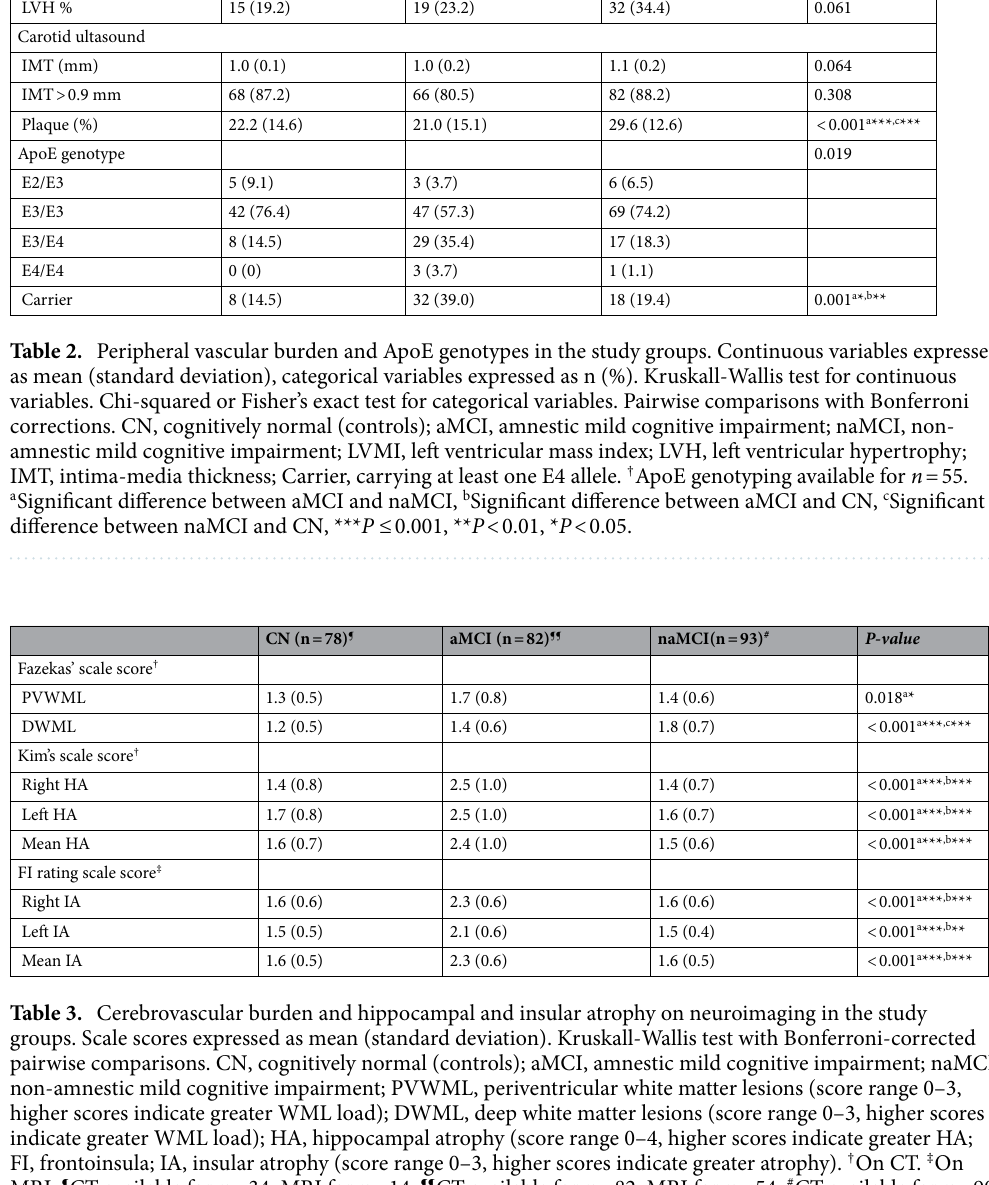
Table 3. Cerebrovascular burden and hippocampal and insular atrophy on neuroimaging in the study groups. Scale scores expressed as mean (standard deviation). Kruskall-Wallis test with Bonferroni-corrected pairwise comparisons. CN, cognitively normal (controls); aMCI, amnestic mild cognitive impairment; naMCI, non-amnestic mild cognitive impairment; PVWML, periventricular white matter lesions (score range 0–3, higher scores indicate greater WML load); DWML, deep white matter lesions (score range 0–3, higher scores indicate greater WML load); HA, hippocampal atrophy (score range 0–4, higher scores indicate greater HA; FI, frontoinsula; IA, insular atrophy (score range 0–3, higher scores indicate greater atrophy). † On CT. ‡ On MRI. ¶ CT available for n = 34, MRI for n = 14. ¶¶ CT available for n = 82, MRI for n = 54. # CT available for n = 90, MRI for n = 56. a Significant difference between aMCI and naMCI, b Significant difference between aMCI and CN, c Significant difference between naMCI and CN, *** P ≤ 0.001, ** P < 0.01, * P < 0.05.